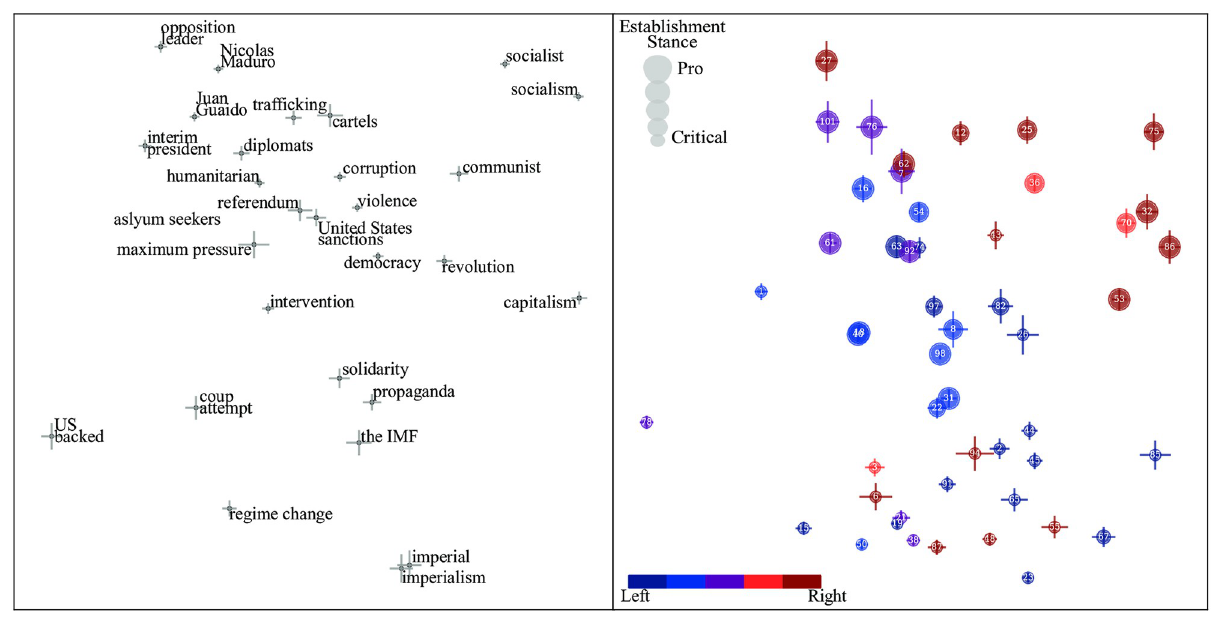
Fig 9. Establishment bias for